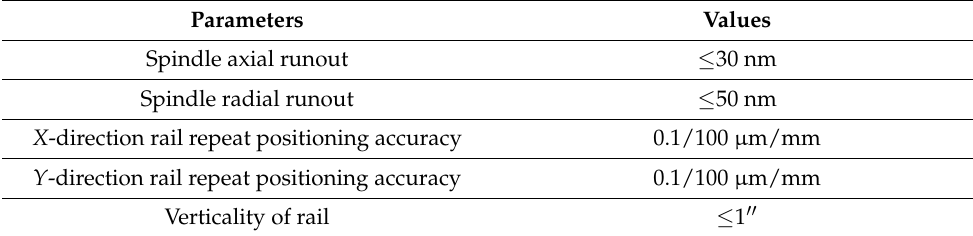
Figure 1. The four-axis ultra-precision lathe with rotary B -axis and FTS system. ( a ) Layout; ( b ) Realization; ( c ) Configuration of sinusoidal microstructures fabrication. Table 1. The specifications of the four-axis ultra-precision